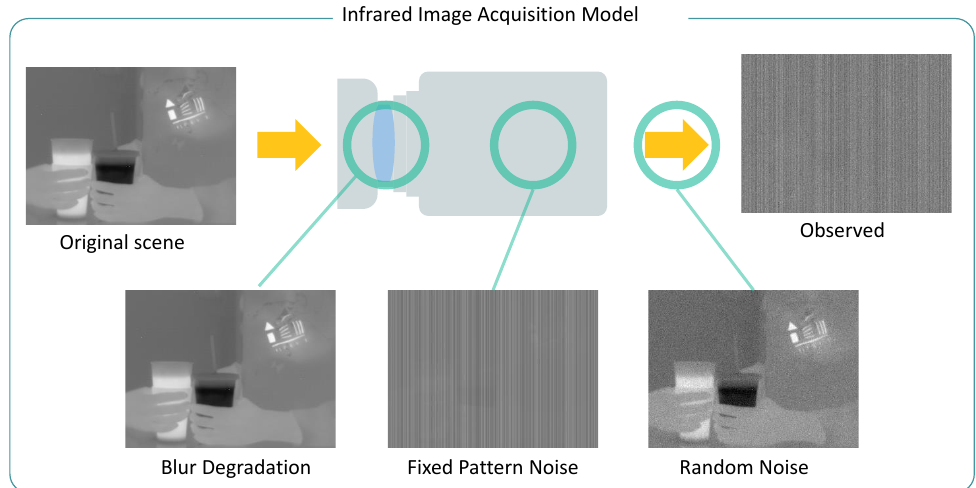
Figure 2. Framework of infrared image acquisition process. For the original scene, blur degradation occurs in the optical system, fixed pattern noise is generated by the responsivity of the sensor, and random noise is acquired during